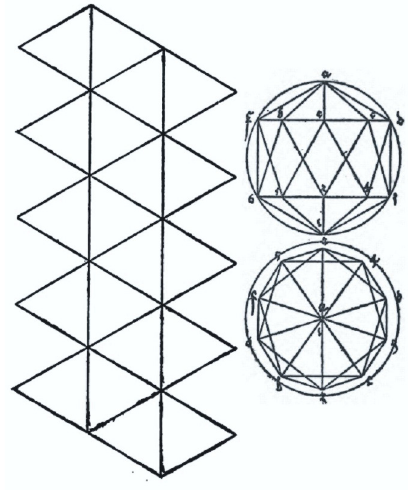
Fig. 9. Sketches of Albrecht Dürer presenting construction of a net of a regular icosahedron